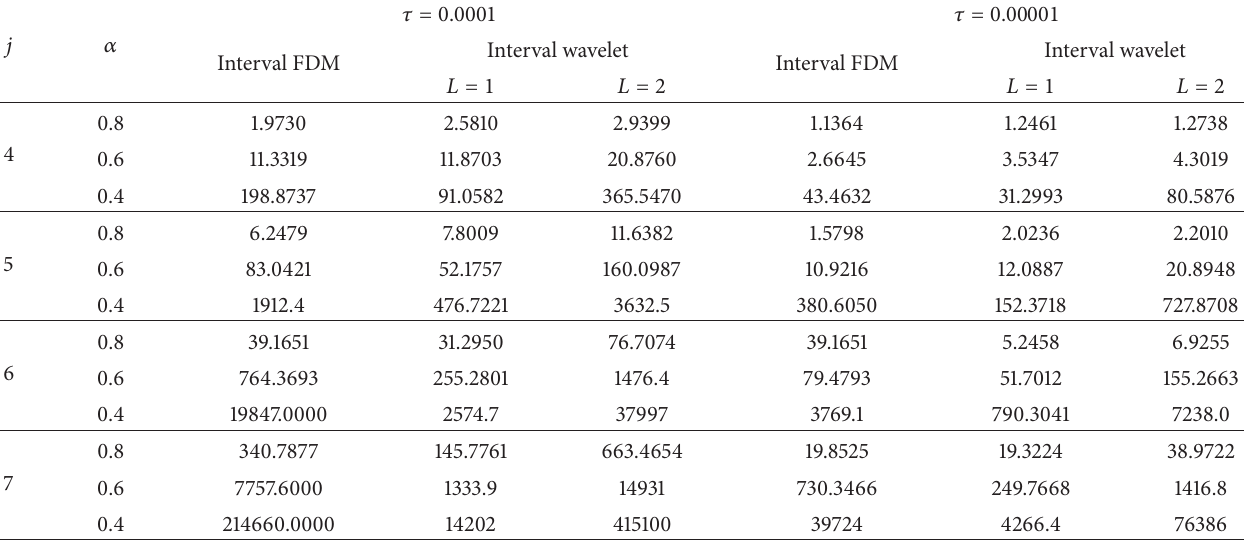
Table 1: Condition number of the Fokker-Planck